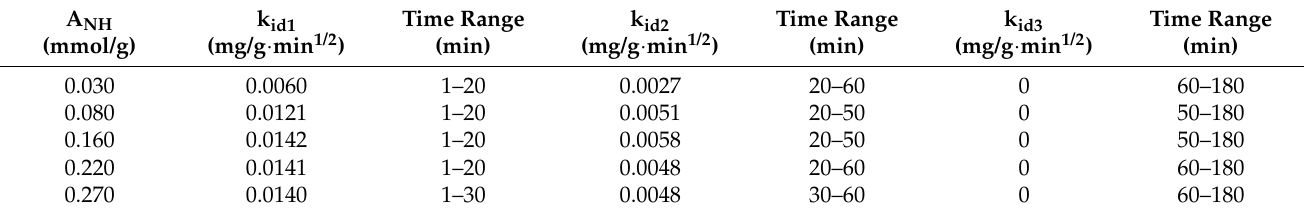
Figure 8. A plot of the adsorbed amount against the square root of t for the AEAPTES-silica beads with the amount of amino groups of 0.030 ( △ ), 0.080 ( □ ), and 0.220 ( ◇ ) mmol/g in a 0.20 mM K 2 Cr 2 O 7 solution at pH 3.0 and 30 °C . Table 4. The intraparticle diffusion constants for adsorption of Cr(VI) ions on AEAPTES-silica beads with different amino groups in a 0.20 mM K 2 Cr 2 O 7 solution at pH 3.0 and 30 °C.